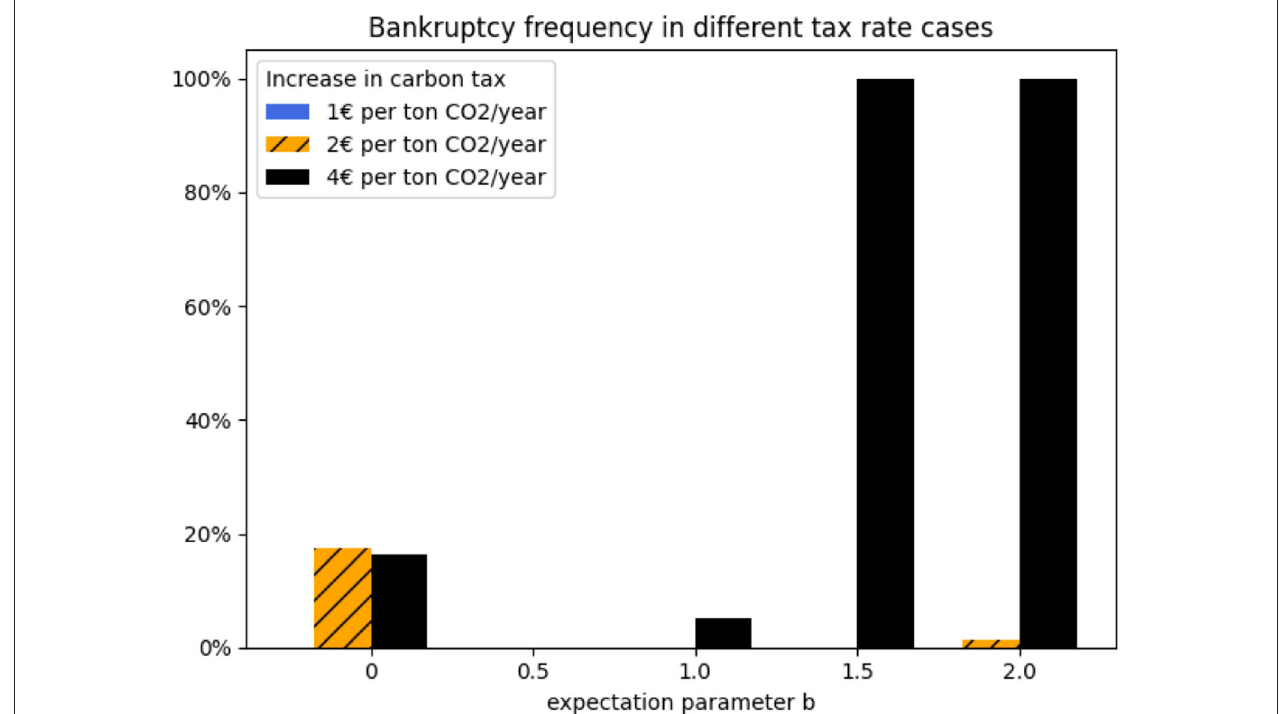
FIGURE 14 | Bankrupt tendency in three different carbon tax scenarios. Note that no agents go bankrupt in the slow tax-increase scenario (increase rate = 1 e per ton CO 2 /year), therefore, the bar is not visible in the figure.